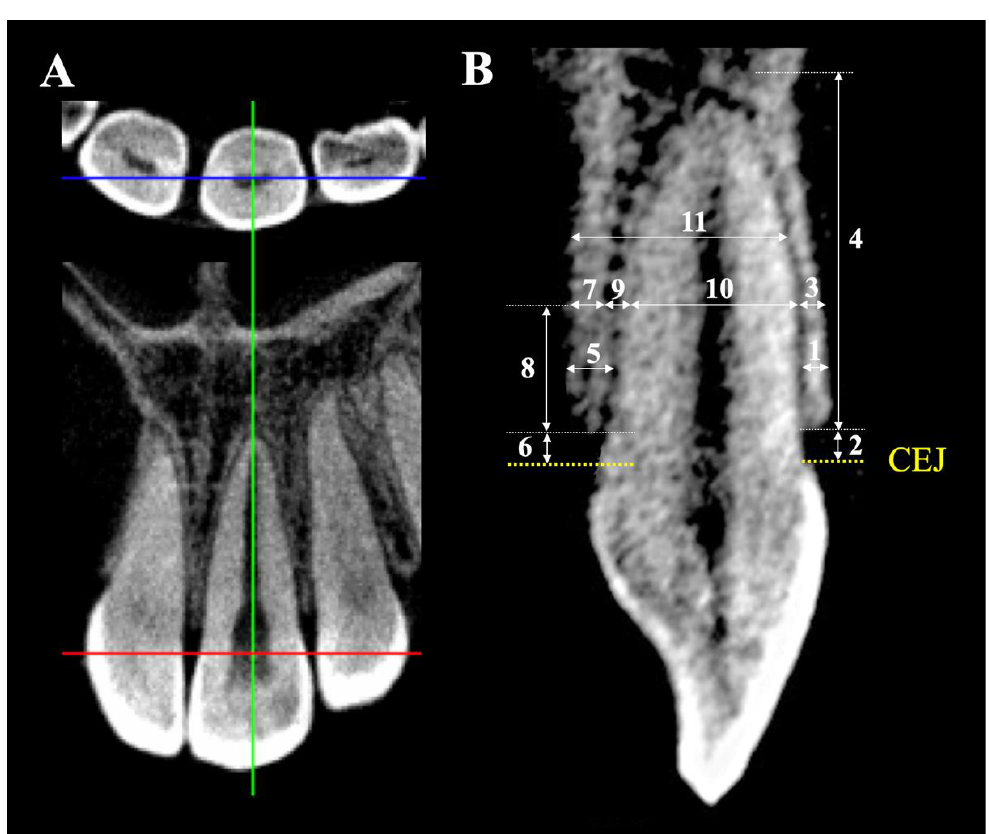
Figure 2. CBCT measurements . ( A ) Tooth orientation of CBCT: the sagittal plane running transversely through the midpoint of the tooth ’s long axis. ( B ) CBCT measurements of (1) to (4) on labial side: (1) labial alveolar bone thickness, (2) labial alveolar bone height, (3) labial cortical bone thickness, (4) labial cortical bone height. CBCT measurements of (5) to (9) on palatal side: (5) palatal alveolar bone thickness, (6) palatal alveolar bone height, (7) palatal cortical bone thickness, (8) palatal cortical bone height, (9) palatal cancellous bone thickness, (10) root diameter, and (11) total root-bone thickness.